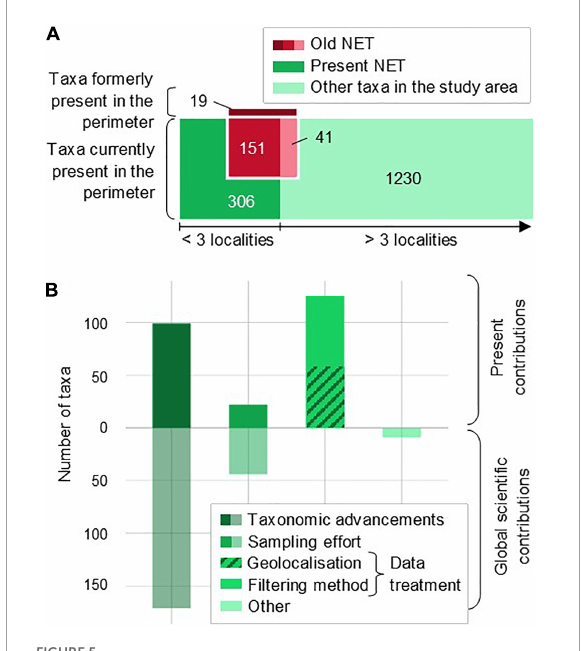
FIGURE5 Narrow endemic taxa (NET) list evolution since the study by Wulff et al. (2013). (A) Distribution of old NET in the present NET list. (B) Number of taxa added by contribution type since 2013 (below), or during this study (above). Contribution types are not